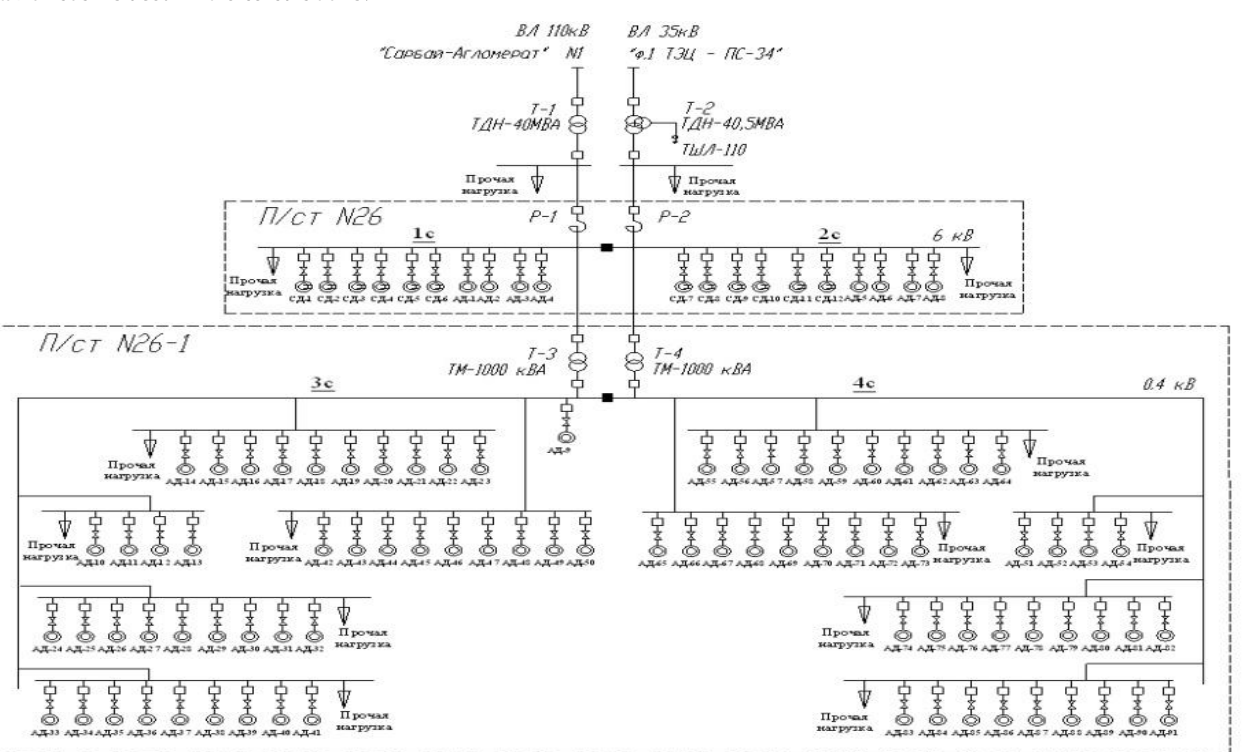
Fig. 1. Design diagram TP-26 JSC